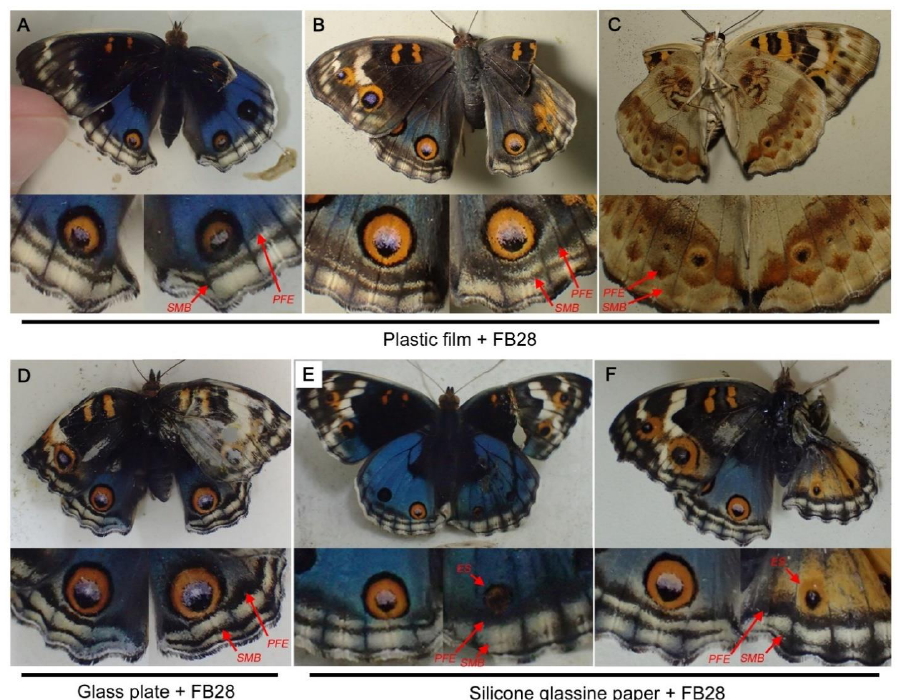
Figure 9. Double treatments with a covering material and the injection of FB28. Only the right dorsal hindwing was treated with a covering material. The top panels show the dorsal view of the treated individuals (the ventral view in C), and the bottom panels show magnification of the posterior eyespots on the hindwings. Eyespot (ES), parafocal element (PFE), and submarginal band (SMB) are indicated by red arrows. ( A – C ) Individuals treated with plastic film and FB28. ( D ) Individuals treated with glass plate and FB28. ( E,F ) Individuals treated with silicone glassine paper and FB28.